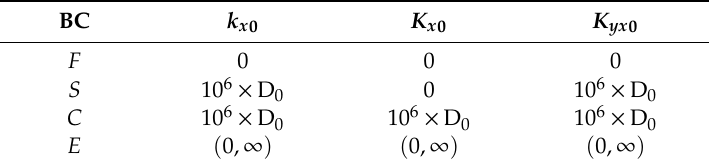
Table 1. Spring sti ff ness under di ff erent boundary conditions.